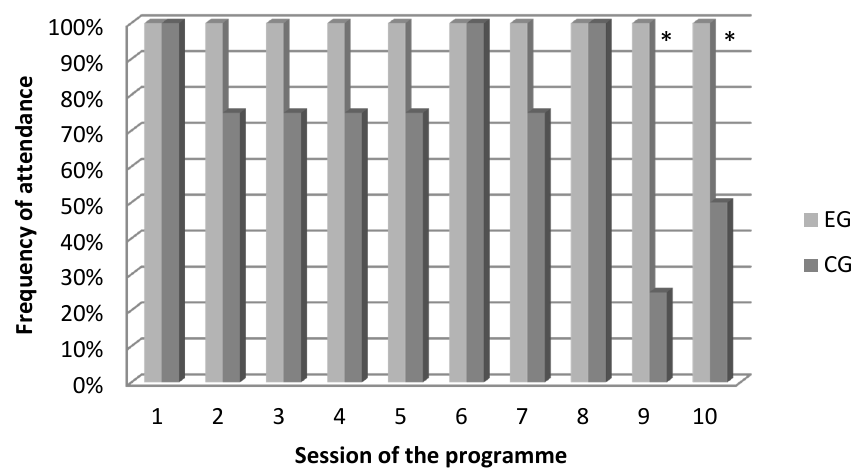
Figure 1. Children’s attendance. EG and CG children. EG = Experimental group; CG = Control Group; * p < 0.05.